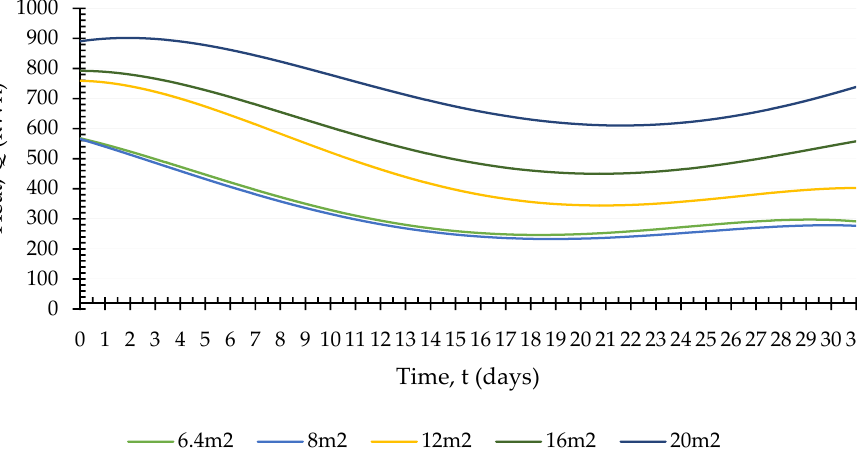
Figure 9. Available heat stored for different solar collector areas based on TES average temperatures for January.